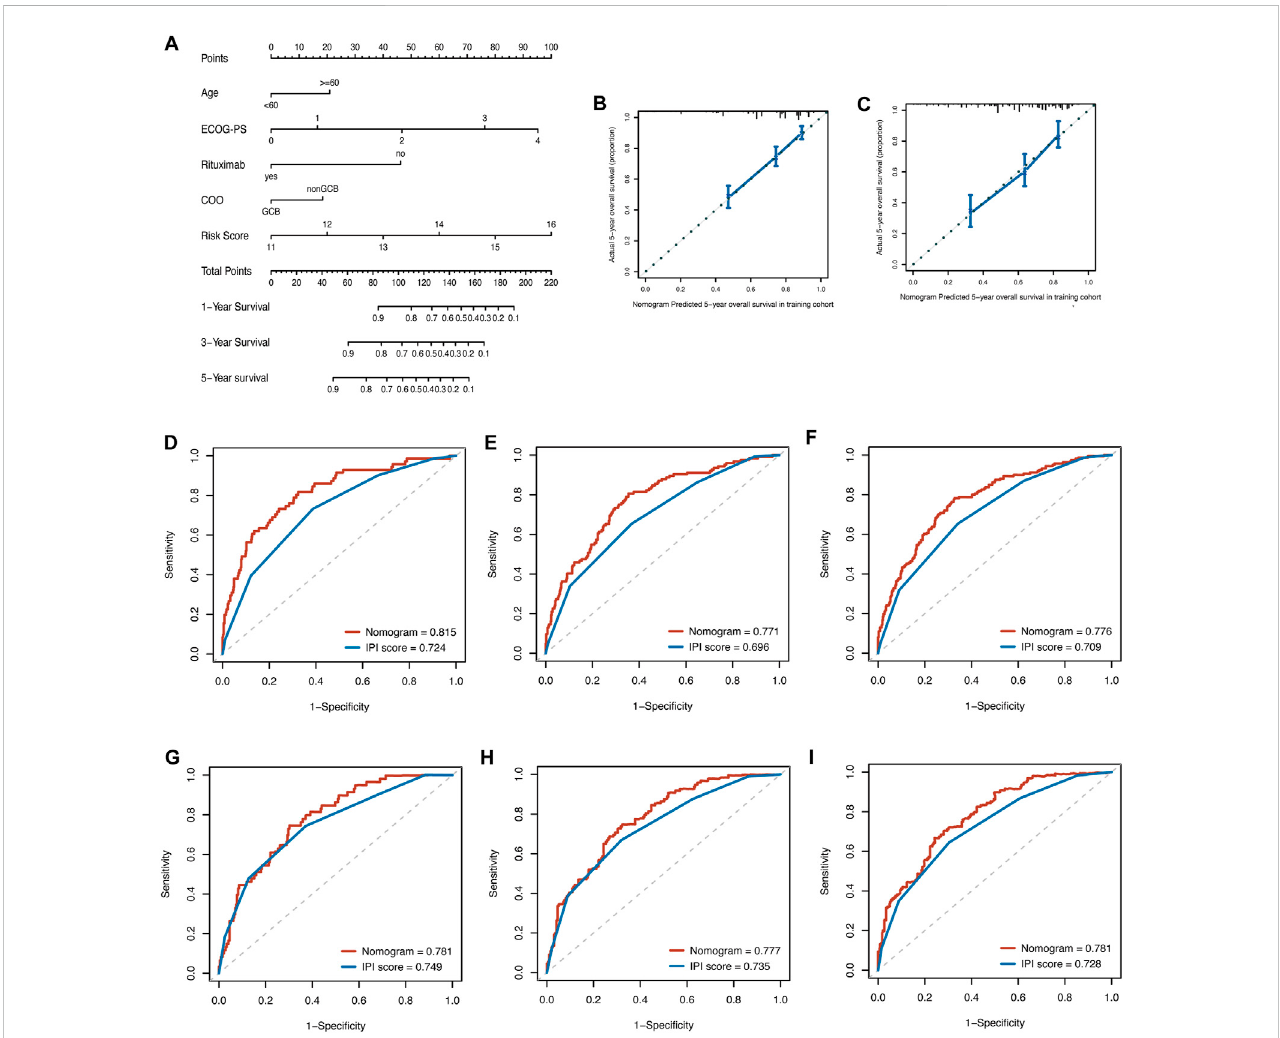
FIGURE 6 Construction of prognostic nomogram for overall survival in patients with DLBCL. (A) The nomogram integrated age, ECOG-PS, use of rituximab, COO, andglycolytic riskscore topredict1-,3-and5-year survival. (B,C) Calibrationplotsof5-yearsurvivalprobabilityintraining cohort(GSE181063) andvalidation cohort (GSE10846). ROC curves of the nomogram and IPI in training cohort (GSE181063, (D – F) for AUCs at 1-, 3-, and 5-year, respectively) and validation cohort (GSE10846, (G – I) for AUCs at 1-, 3-, and 5-year, respectively). DLBCL, diffuse large B-cell lymphoma; ECOG-PS, Eastern Cooperative Oncology Group performance status; COO, cell of origin; ROC, receiver operating characteristic; IPI, international prognostic index; AUC, area under the